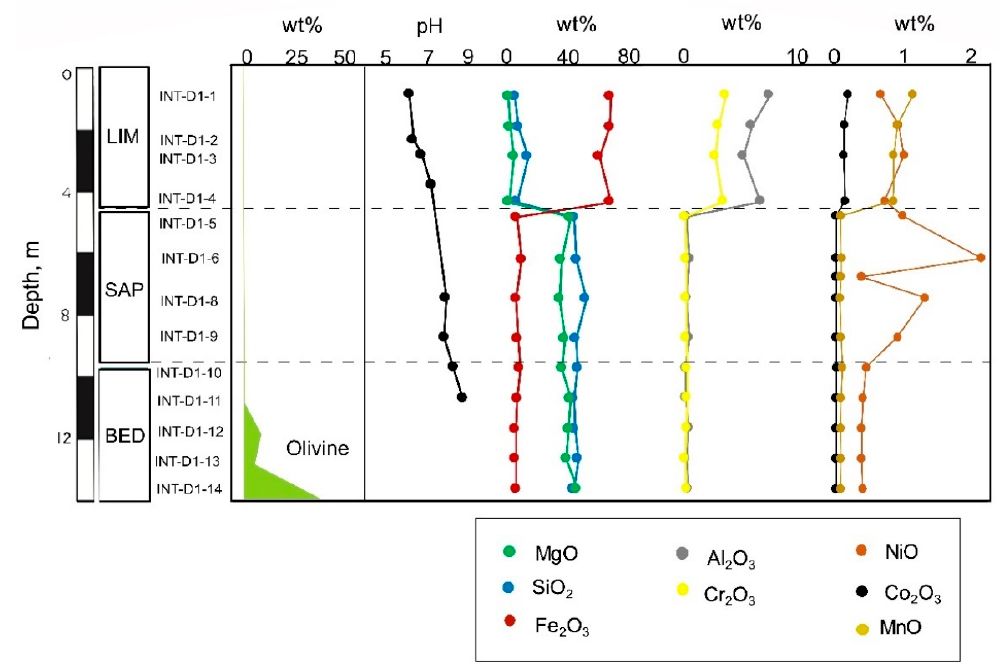
Figure 15. Distribution of olivine, pH and elements with depth in the laterite derived from lherzolite bedrock (BB2515 core).